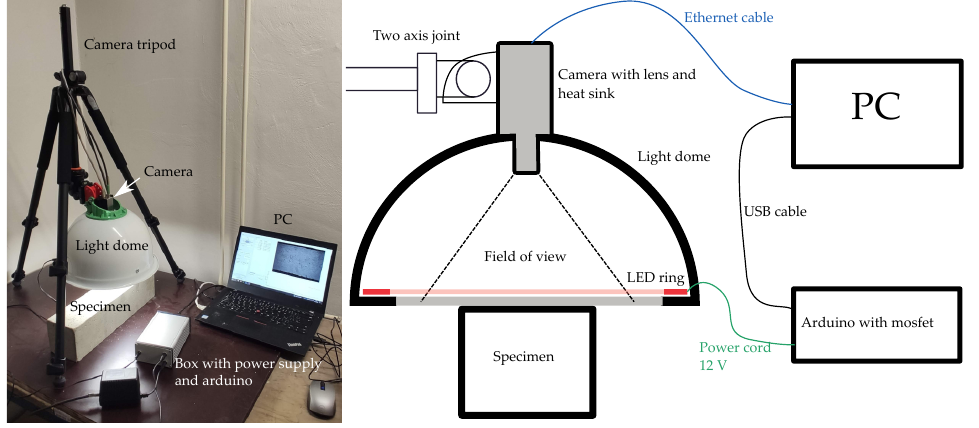
Figure 4. Scheme of camera setting used for image acquisition.